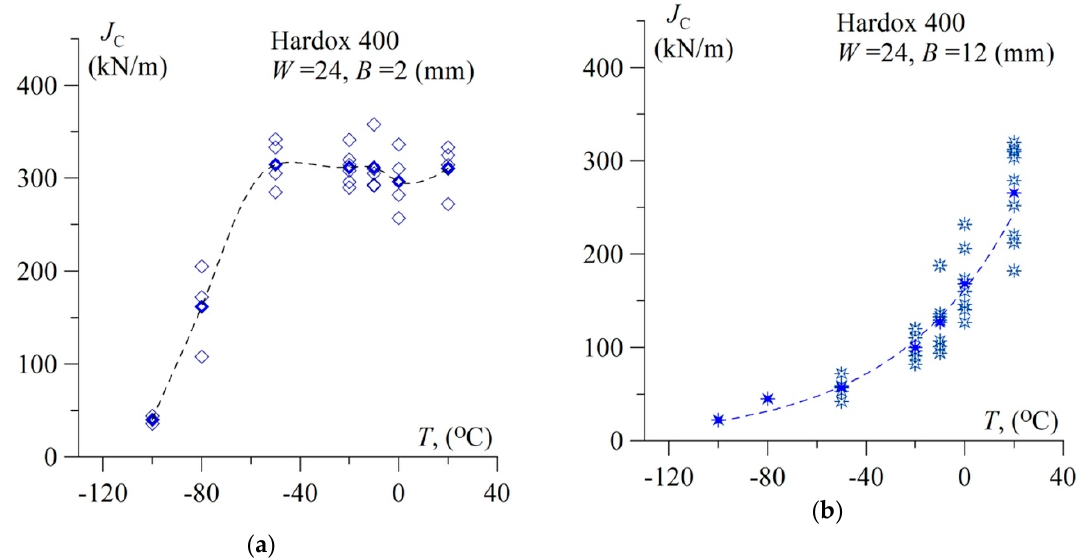
Figure 5. The critical values J C with temperature changes for ( a ) specimens of 2 mm and ( b ) 12 mm thickness.